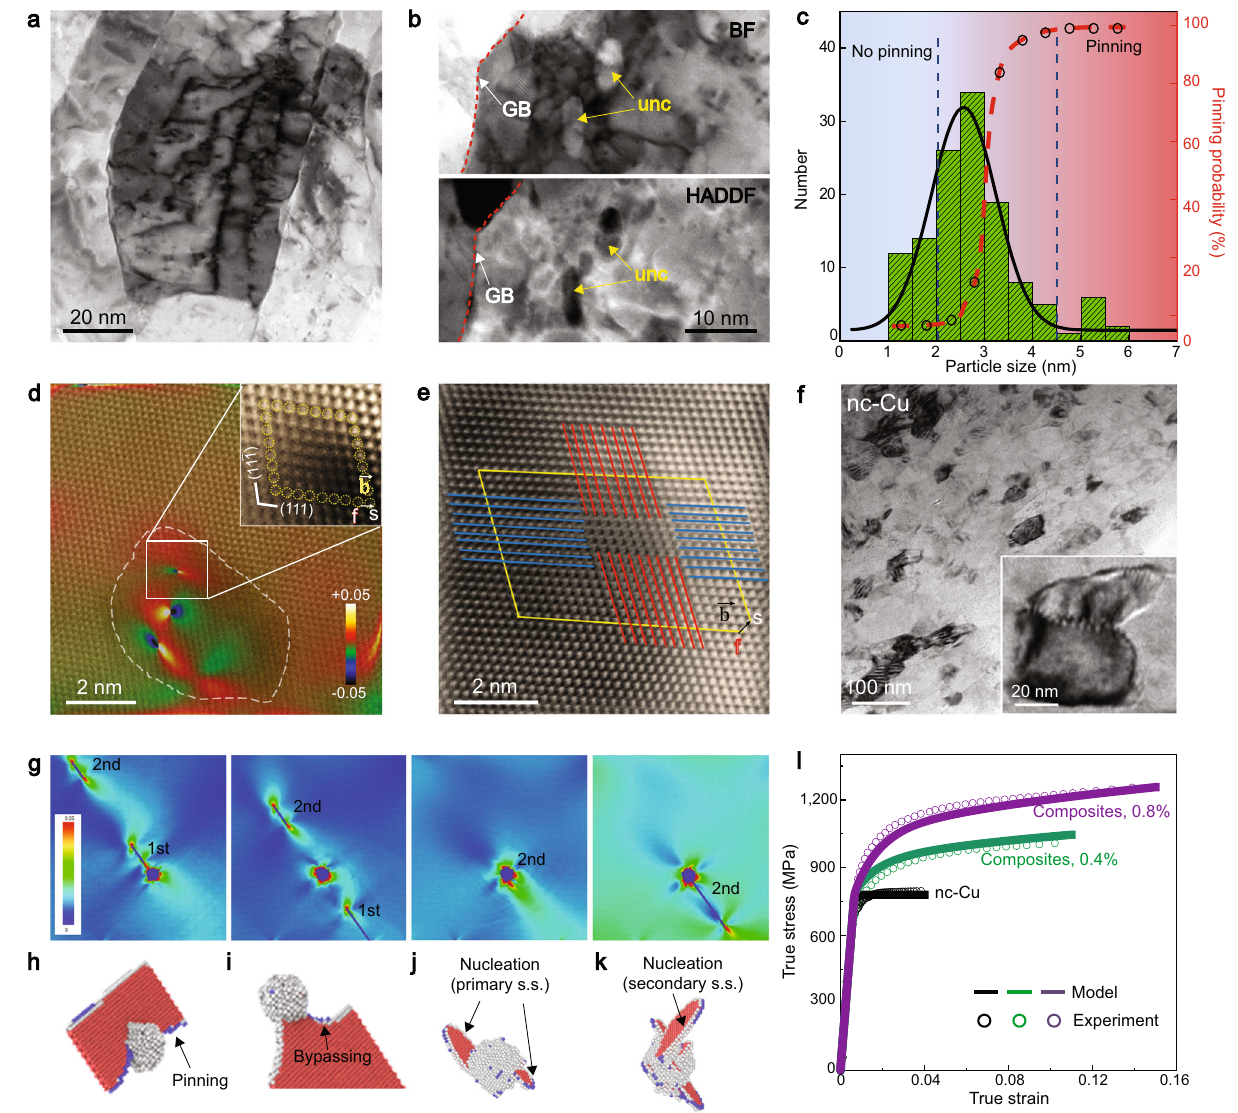
Fig. 4 | Strengthening and hardening mechanisms in nc-Cu composites. a BF - STEM image of an nc-Cu composite (0.8 vol.% C) after tensile fracture. A high density of dislocations was stored inside nanograins. b BF- and HAADF-STEM images of the same region. c Size distribution histogram of unc particles and cor- responding dislocation pinning probability. 127 particles were examined. Unc particleswithlargerdiametersarefoundtohaveahigherprobabilityofdislocation pinning. d Ahigh-resolutionHAADF-STEMimageshowsatomicstructurenearaunc particle, superimposed with the dilatation strain ( ε xx ) map. The zero-strain refer- encewaschoseninthe lower-leftcornerof thisimage. Threedislocation cores can be identi fi ed at the C nanoparticle region (indicated by the yellow dashed circle). The Burgers circuit analysis (inset) of one dislocation indicates the Burgers vector of 1/2[011]. e High-resolution HAADF-STEM image of the deformed microstructure away from unc particles. Two full dislocations on different {111} planes form an immobile Lomer lock, as revealed by the Burgerscircuit analysis. f BF - STEMimage of the tensile fractured pure nc-Cu. Few dislocations were stored. Inset is a